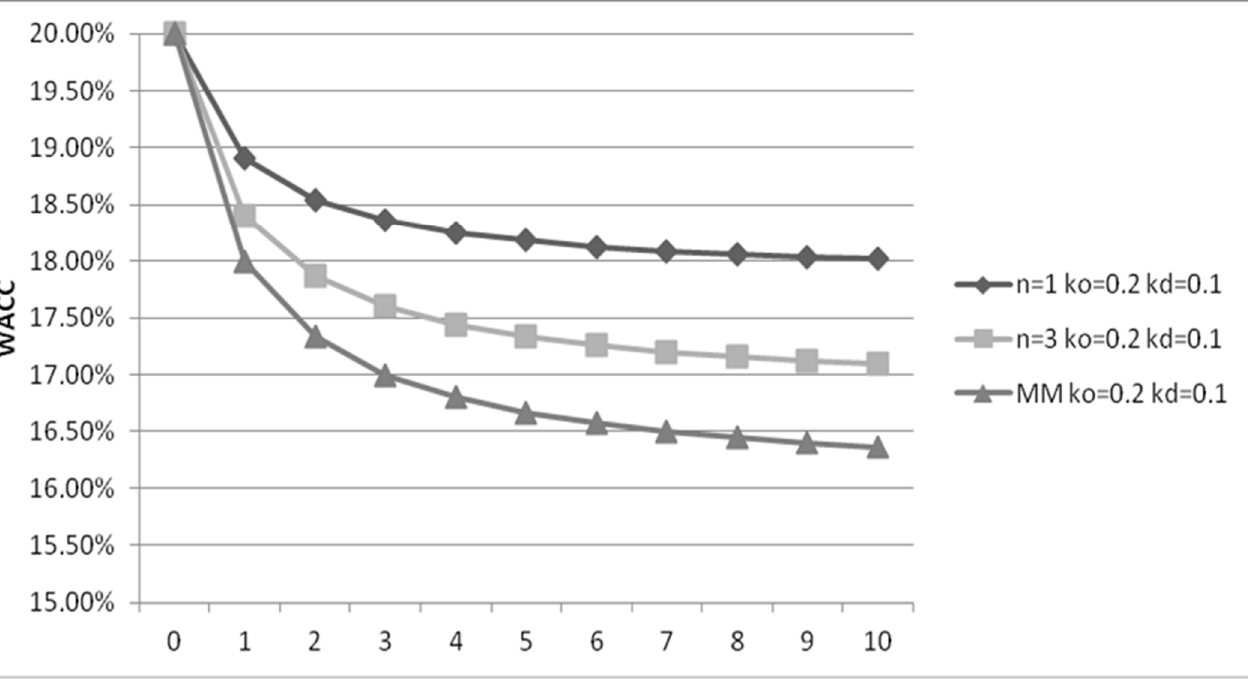
Figure 1. Dependence of WACC on leverage level, L, for different ages of the company: n = 1, n = 3, and n = ∞